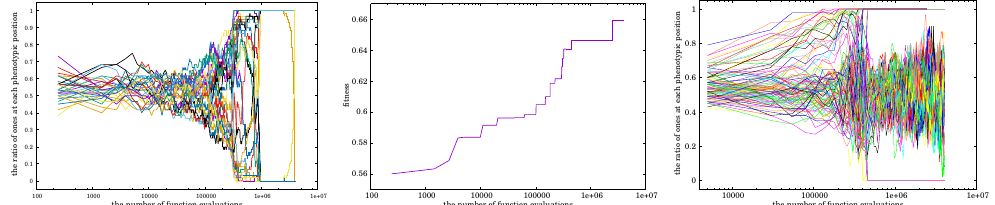
( h ) Fitness convergence curve for for NK-LAND ( (cid:96) = 30) when using the EDT with P =60 and T c = (cid:100) (cid:96) /8 (cid:101) .